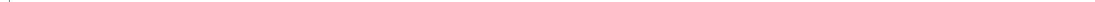
Figure 6: HIS mice can be persistently infected with Epstein-Barr virus (EBV) and develop immune responses to the infection. Mice that have been reconstituted by means of neonatal intrahepatic injection with human CD34 + haematopoietic progenitor cells develop viraemia upon intraperitoneal EBV infection. Lytic replication deficient virus (BZLF1-) has a lower viral titre at 3 weeks after infection. NK cells expand to lytic EBV infection at 4 weeks after infection and CD8 + T cells react to both lytic and latent infection with expansion by 5 weeks of